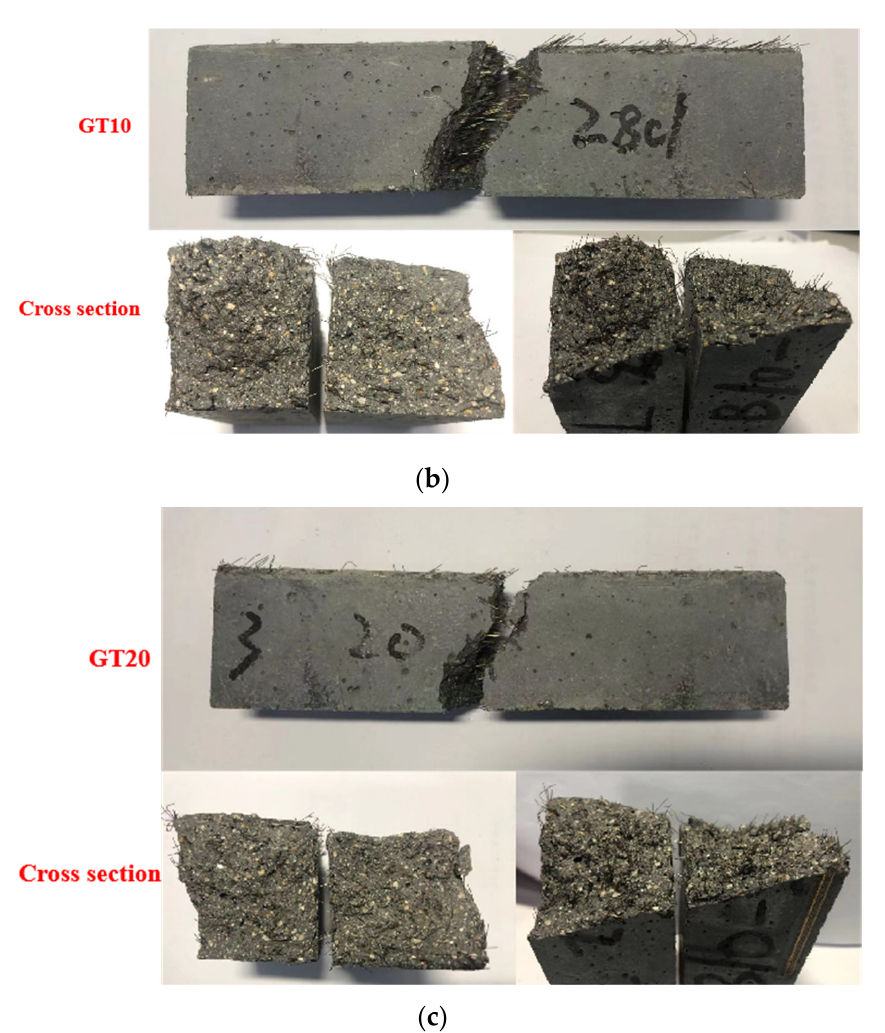
Figure 21. The selected flexural specimens and their cross-sections. ( a ) GT00 and its cross-sections; ( b ) GT10 and its cross-sections; ( c ) GT20 and its cross-sections.